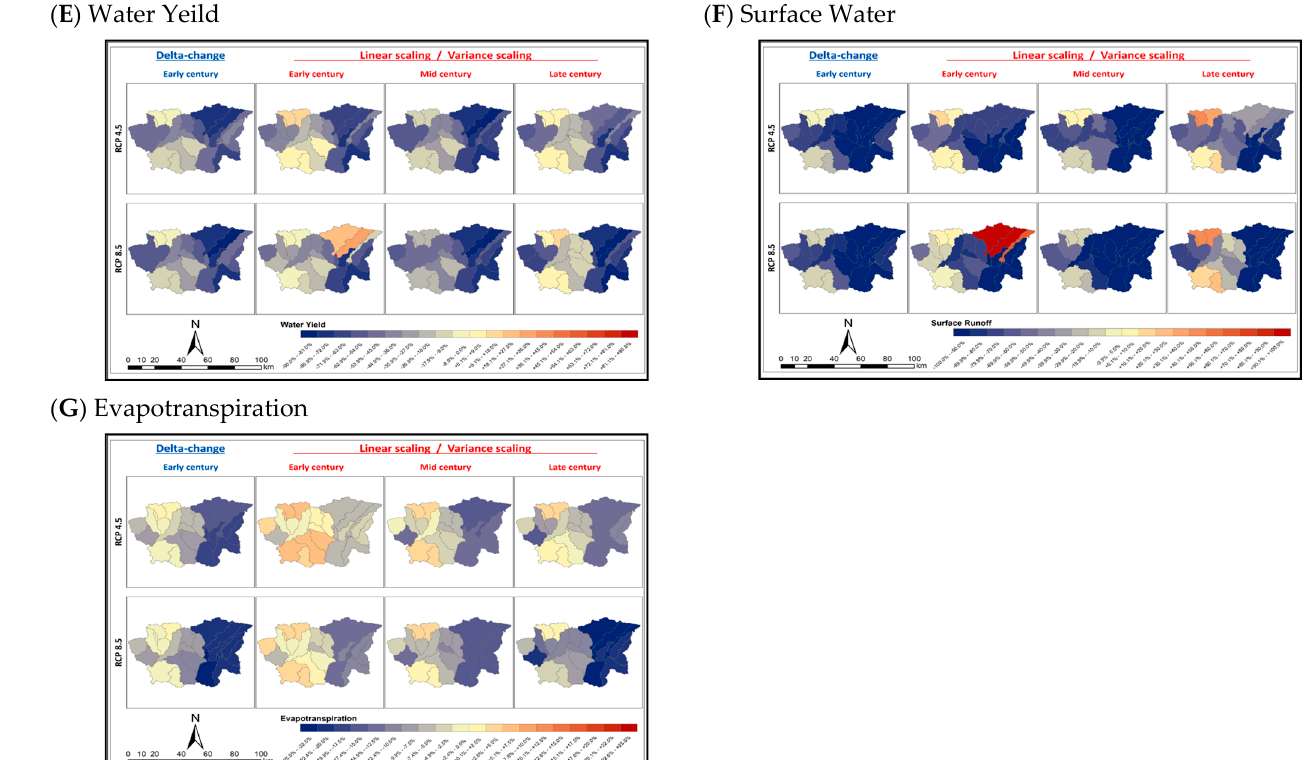
Figure 13. Simulated changes over AZB relative to the reference period under future scenarios.